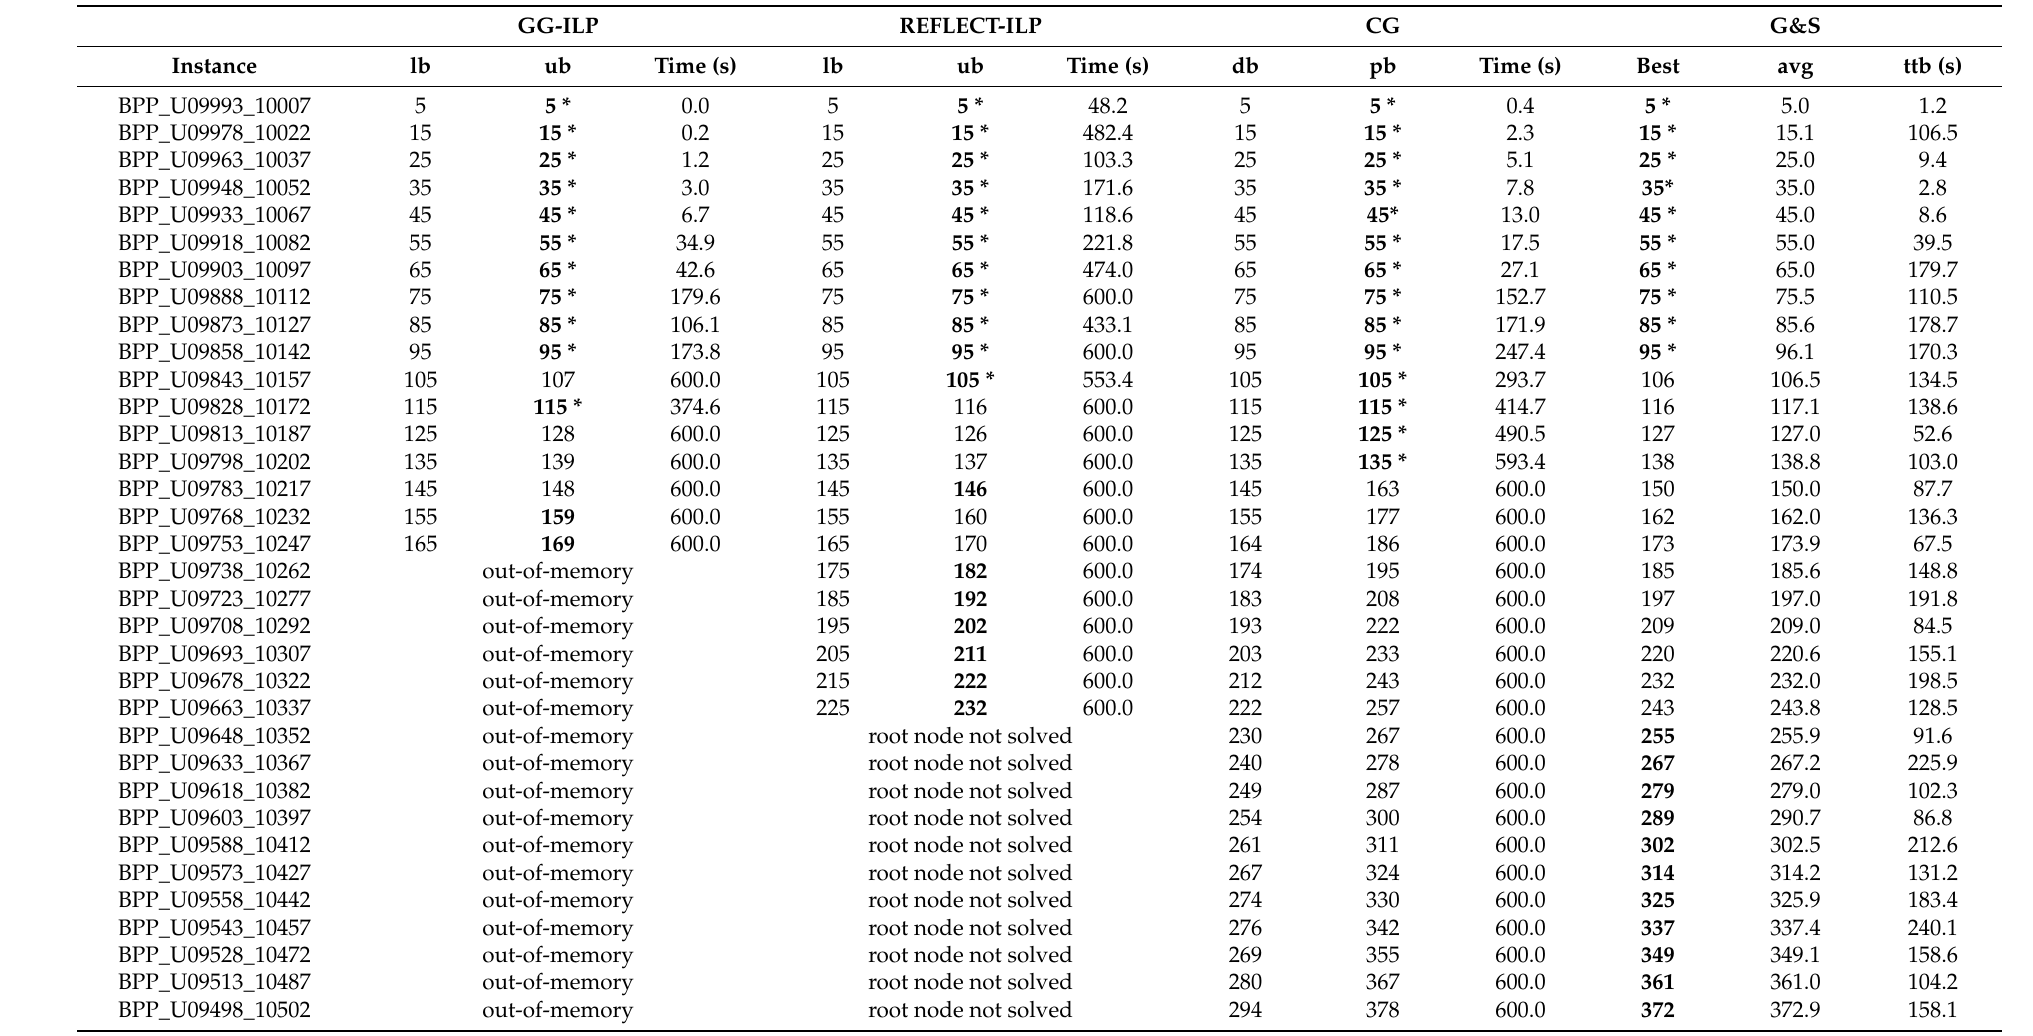
Table 1. Results for the set of instances of class U